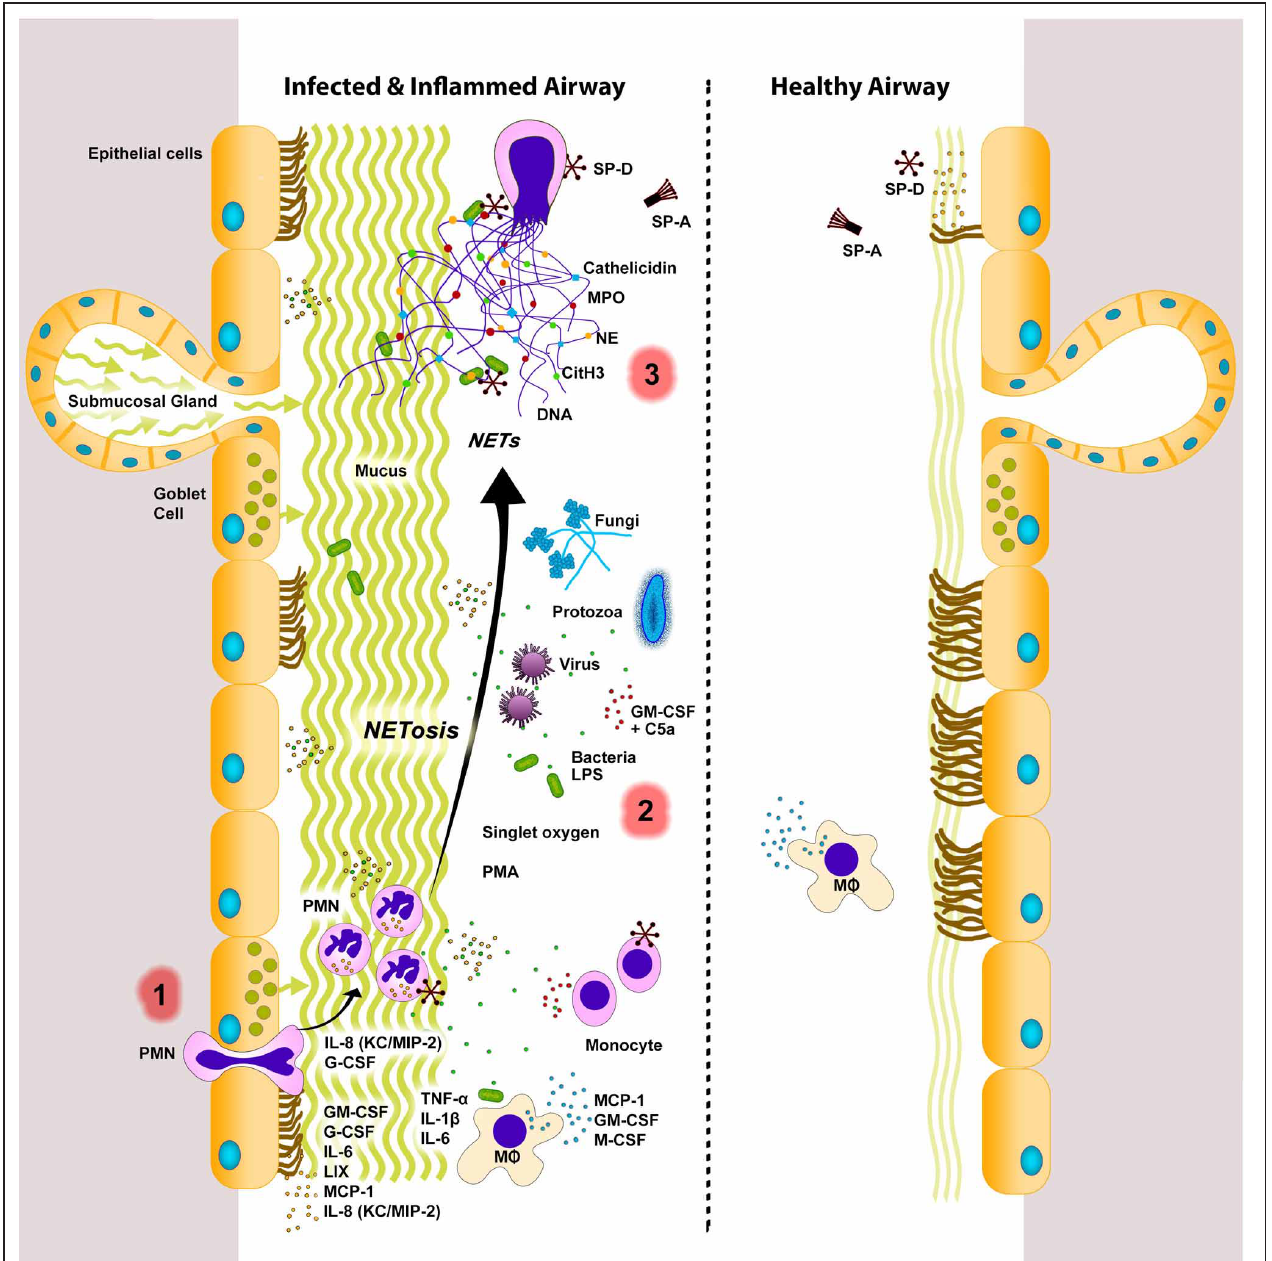
FIGURE 1 | NETs in infected and inflamed airways. Lungs respond to sterile injury or infection by secreting various signaling molecules. During infection and inflammation, various cells (e.g., endothelial, epithelial, immune cells) express inflammatory cytokines, chemokines, and growth factors to recruit monocytes (e.g., MCP-1) and neutrophils [e.g., IL-8 (KC/MIP-2)] into the airway lumen. Neutrophils can be stimulated by a variety of agents (e.g., bacteria, viruses, fungi, protozoa, LPS, singlet oxygen, PMA, GM-CSF + C5a) to undergo NETosis. Release of cytotoxic DNA–protein complexes [e.g., citrullinated histone (CitH 3 ), neutrophil elastase (NE), myeloperoxidase (MPO), cathelicidin, other neutrophil proteases] not only increase mucus viscosity, but also contribute to lung damage that can perpetuate the vicious cycle of lung injury and inflammation. NETs are considered to be degraded by DNase enzymes.